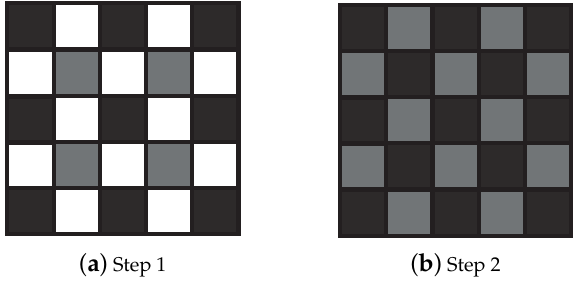
Figure 6. Neighborhood used for weight computation in any channel according to the step of binary-three edge sensing (BTES) algorithm. Pixels in black are known or previously estimated, whereas pixels in gray are the estimated pixels. Pixels in white are unknown and not estimated at the current